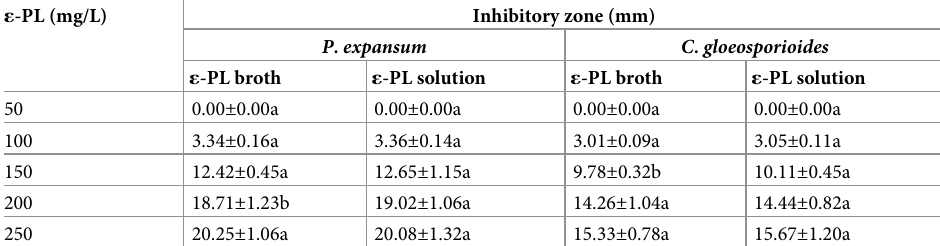
Table 2. In vitro antifungal activity of the broth and ε -PL solution against P . expansum and C . gloeosporioides .